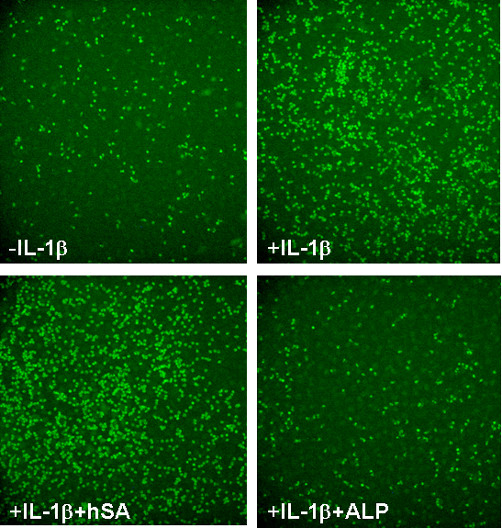
Inhibition of leukocyte attachment to IL-1β-treated EA.hy 926 cells by antileukoproteinase in vitro. Adherence of human CFDA-SE (carboxyfluorescein diacetate succinimidyl diester)-labelled granulocytes to layers of EA.hy 926 cells was assessed by fluorescence microscopy. A comparison of granulocyte adherence to EA.hy 926 cells that were either untreated (- IL-1β) or cytokine-stimulated (+IL-1β) is shown. Pretreatment of EA.hy 926 cells with 5 μM antileukoproteinase (ALP) (+IL-1β +ALP) but not with 5 μM hSA (+IL-1β +hSA) resulted in a marked decrease in granulocyte adhesion.